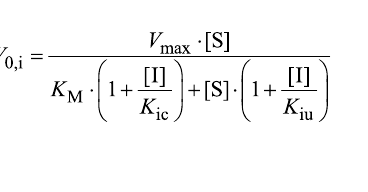
where: V max = maximum reaction velocity, K M = Michaelis constant, K ic = competitive inhibitory constant, K iu = uncompetitive inhibitory constant, [S] = concentration of the substrate, [I] = concentration of the